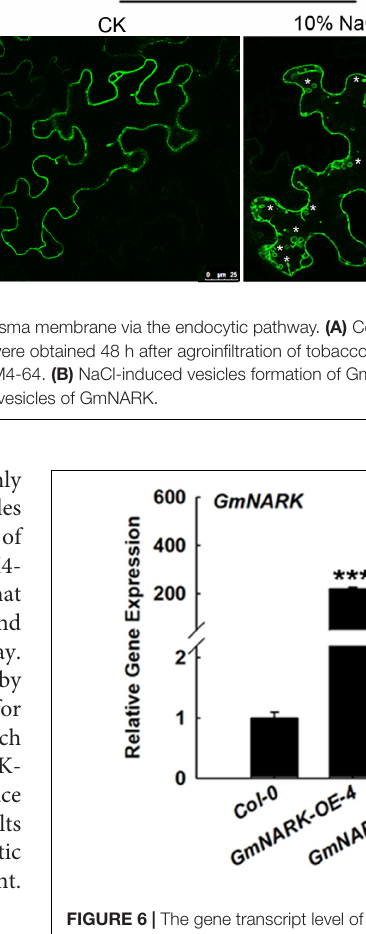
FIGURE 6 | The gene transcript level of GmNARK in GmNARK overexpression seedlings in Arabidopsis thaliana . The gene transcript level of overexpression of GmNARK , RNA was extracted from the 7-day-old Arabidopsis transgenic seedlings grown on MS medium, three independent experiments were performed with similar results, each with three replicates. The Student’s t -test was performed and the statically significant treatments were marked with ‘ ∗∗∗ ’ ( P <